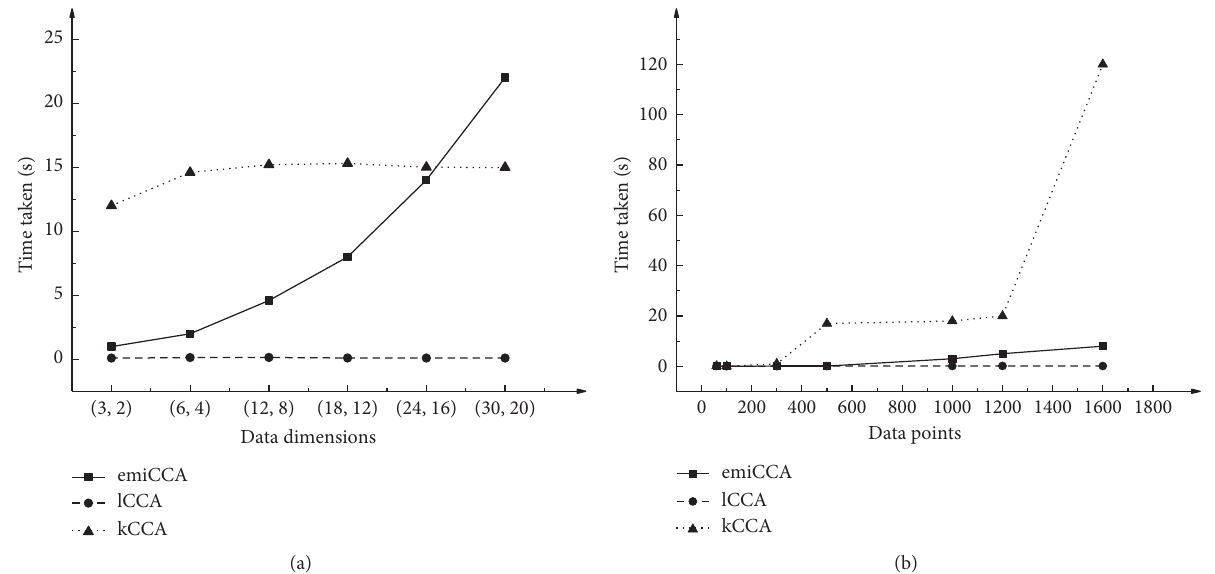
Figure 7: Time-consuming changes produced by the emiCCA, lCCA, and kCCA methods: (a) different data dimensions and (b) different data points.